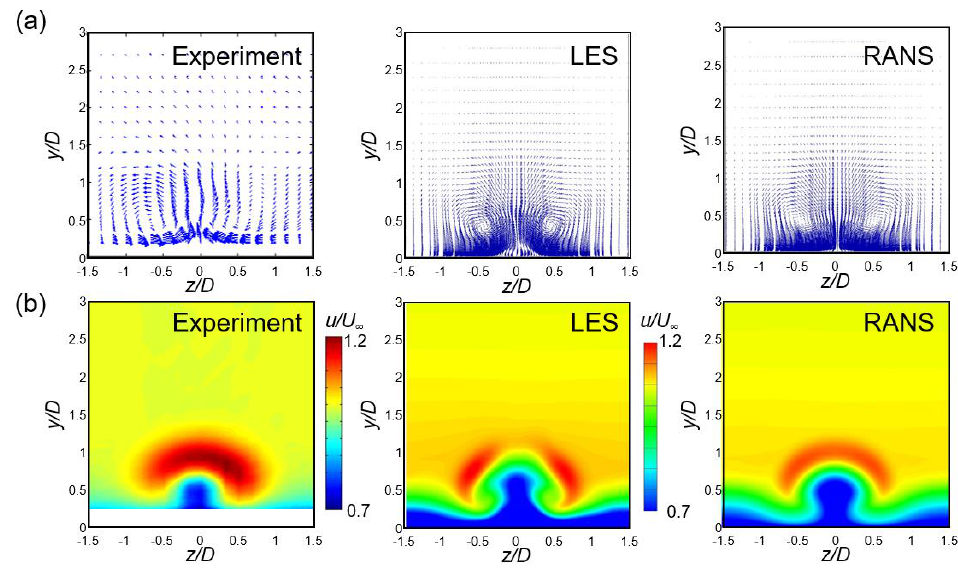
Figure 3. Flow field at x/D = 2.5 for M = 1.0 [5]: ( a ) Cross-stream velocity vectors and ( b ) streamwise velocity contours.